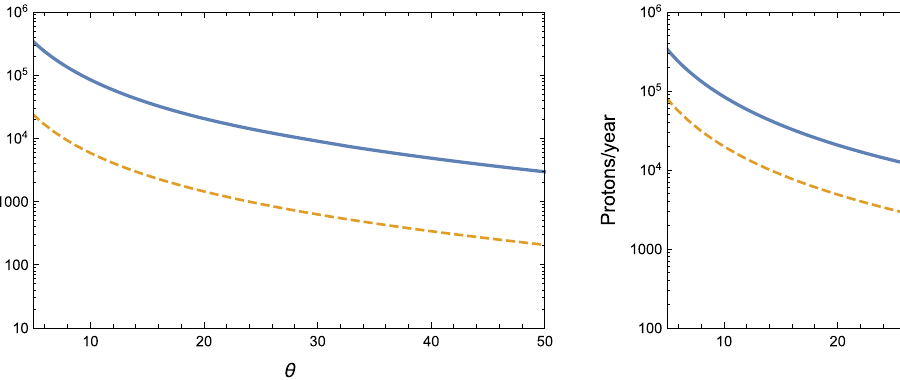
Fig. 9 We show the average number of protons scattered in 1 year from a proton beam at an LHC luminosity of 2 10 34 cm − 2 s − 1 by monopolium moving at velocity β = 0 . 01 as a function of scattering angle for the geometry that maximises the cross section. Left: for k = 7